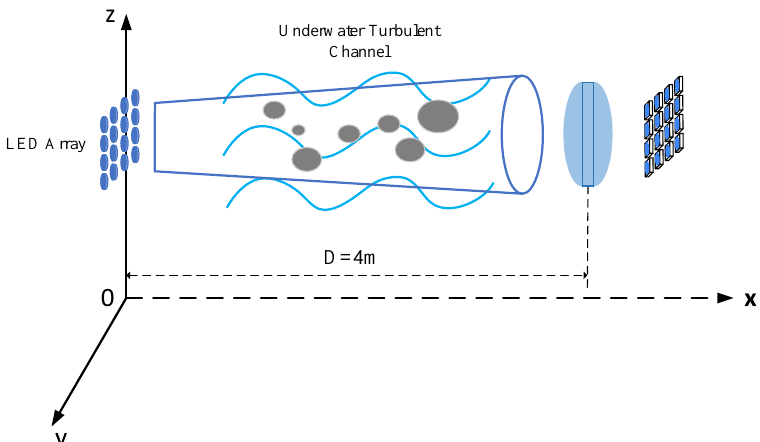
Figure 1. Underwater optical imaging communication system model.